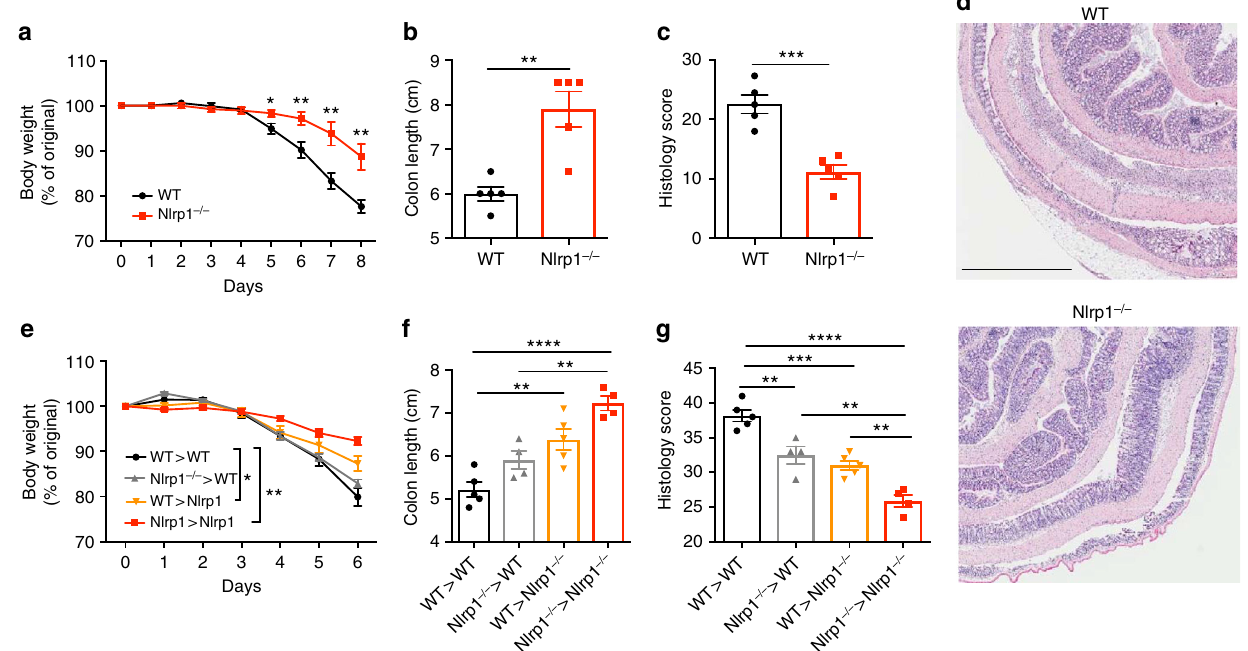
Fig. 1 Loss of NLRP1 confers protection against DSS-induced colitis. WT and Nlrp1 − / − mice were given 3% (w/v) DSS for 6 days followed by normal drinking water for 2 days and disease severity was measured according to a percentage weight loss, b colon length and c histology score for epithelial damage and in fl ammatory cell in fi ltrate of hematoxylin and eosin (H&E)-stained sections of the colon, scale bar = 1 mm. d Representative H&E-stained sections of the colon from WT and Nlrp1 − / − mice. Lethally irradiated WT and Nlrp1 − / − mice were reconstituted with WT or Nlrp1 − / − bone marrow for 12 weeks and were given 3% DSS for 6 days. Disease severity was measured by e percentage weight loss, f colon length and g histology score. Data are representative of 3 independent experiments with 3 – 5 mice per group. Means ± SEM; * p ≤ 0.05, ** p ≤ 0.01, *** p ≤ 0.001, **** p ≤ 0.0001. As determined